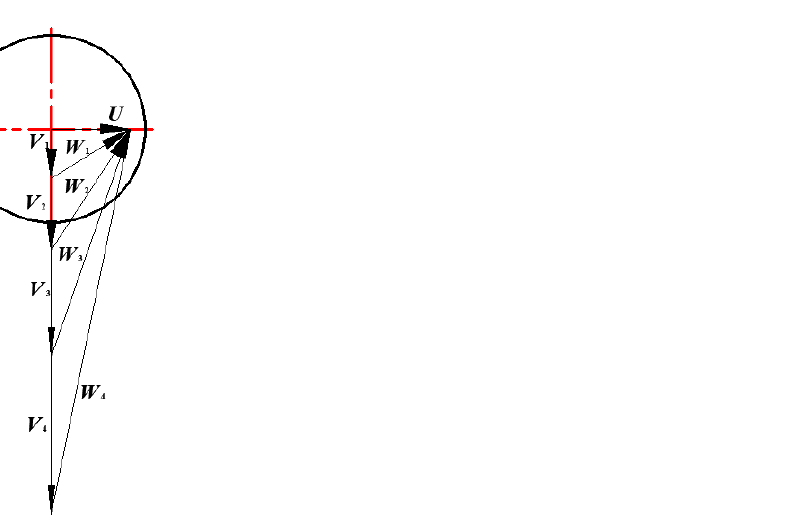
Figure 18. Sketch map of the direction of relative wind speed.